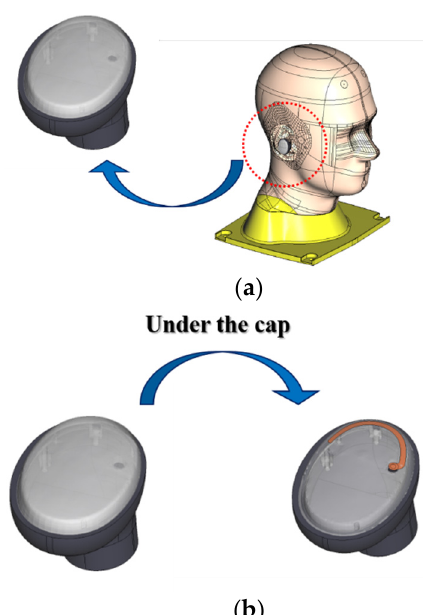
Figure 1. The earphone placed in the ear of the SAM: ( a ) overall view; ( b ) antenna in the earbud.